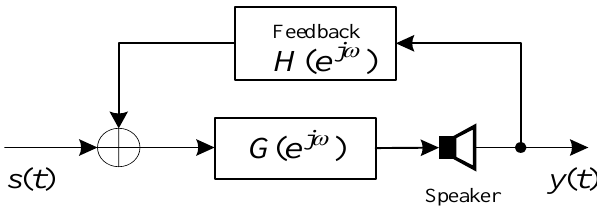
Figure 1. The model diagram of the hearing aid